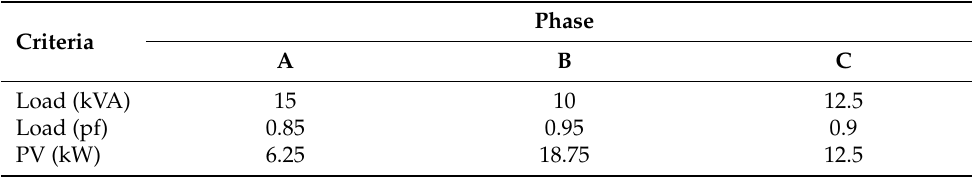
Table 1. Distribution of load and PV injection for each